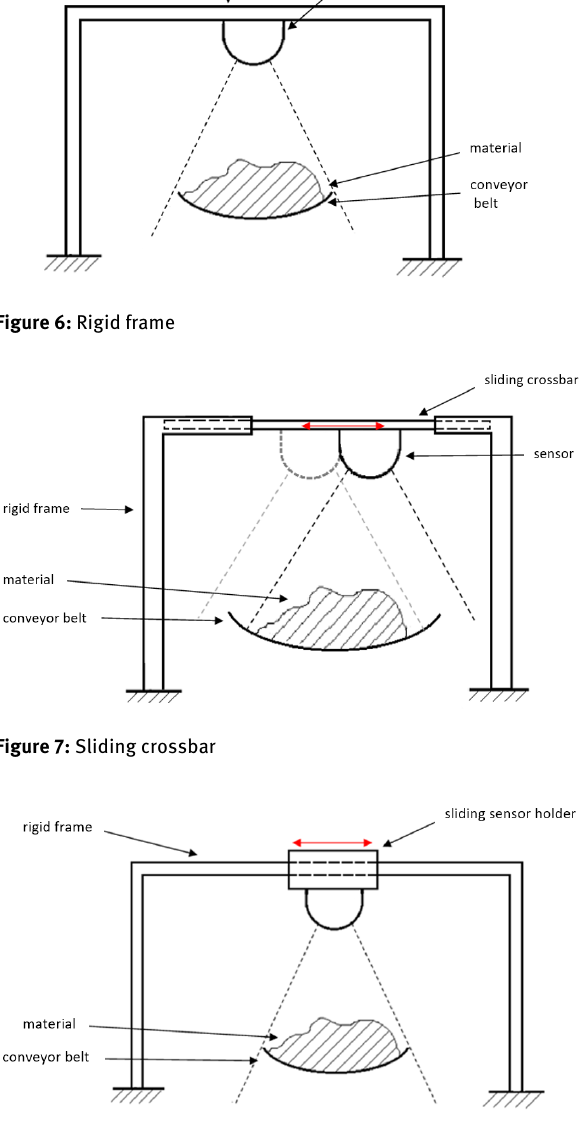
Figure 8: Rigid frame with sliding holder in 1 axis